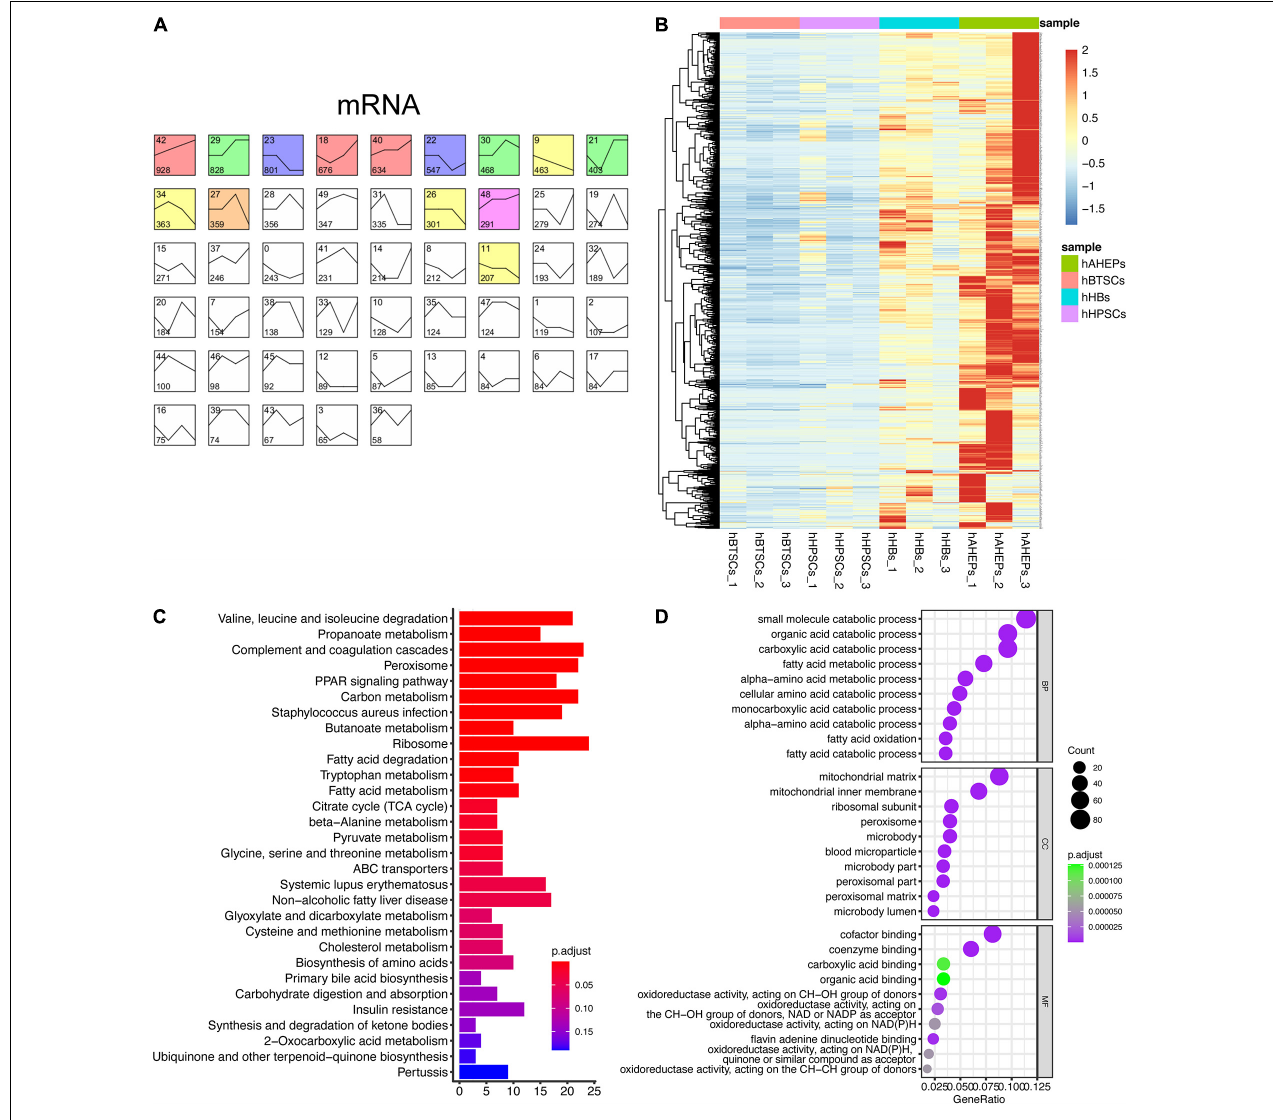
FIGURE 2 | Upwardly expressed mRNAs during hBTSCs lineage commitment. (A) STEM analysis of the mRNA-seq data. Significant profiles are colored, and the same color represents a similar expression pattern. (B) Heatmap of 928 mRNAs which are gradually upregulated from hBTSCs to hAHeps. (C) KEGG enrichment analysis of 928 mRNAs using the package clusterProfier. Top 30 significant terms are shown. (D) GO enrichment analysis of 928 mRNAs using the package clusterProfier. Top 10 significant terms of biological process (BP), cell component (CC), and molecular function (MF) are shown,